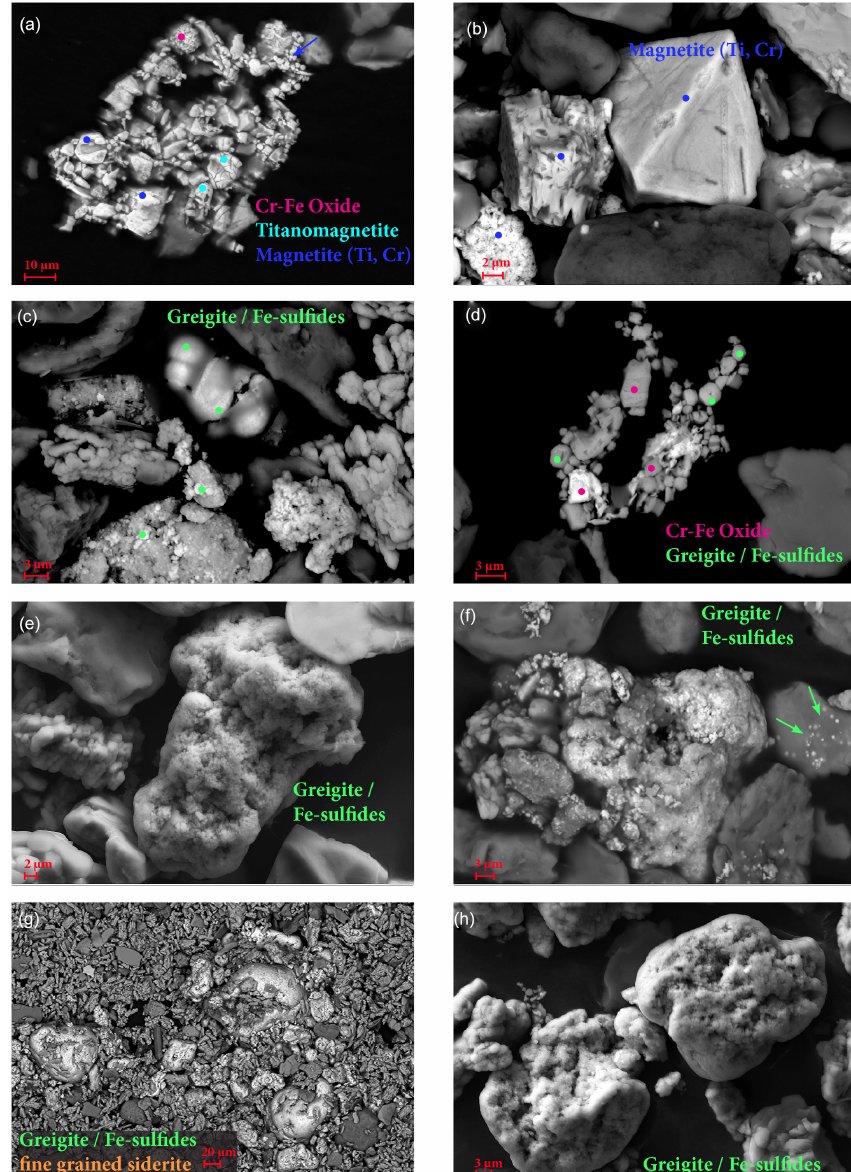
Figure 3. SEM images of magnetic extracts; see also Table 1. (a) 72.53m depth, detrital chromium iron oxides, titanomagnetite and magnetite with traces of Cr and Ti. (b) 10.53m depth, idomorphic and fragments of magnetites, traces of Ti and Cr. (c) 158.83m depth, microcrystalline and framboidal iron sulfides within organic shell. (d) 162.47m depth, chromium iron oxides, fine-grained greigite aggregates. (e) 153.83m depth, microcrystalline iron sulfide nodule. (f) 153.83m depth, microcrystalline iron sulfide aggregates, idiomorphic greigite crystals (ar- rows). (g) 117.83m depth, coarse Fe-S nodules and fine-grained siderite grains (elongated particles). (h) 176.87m depth, microcrystalline iron sulfide